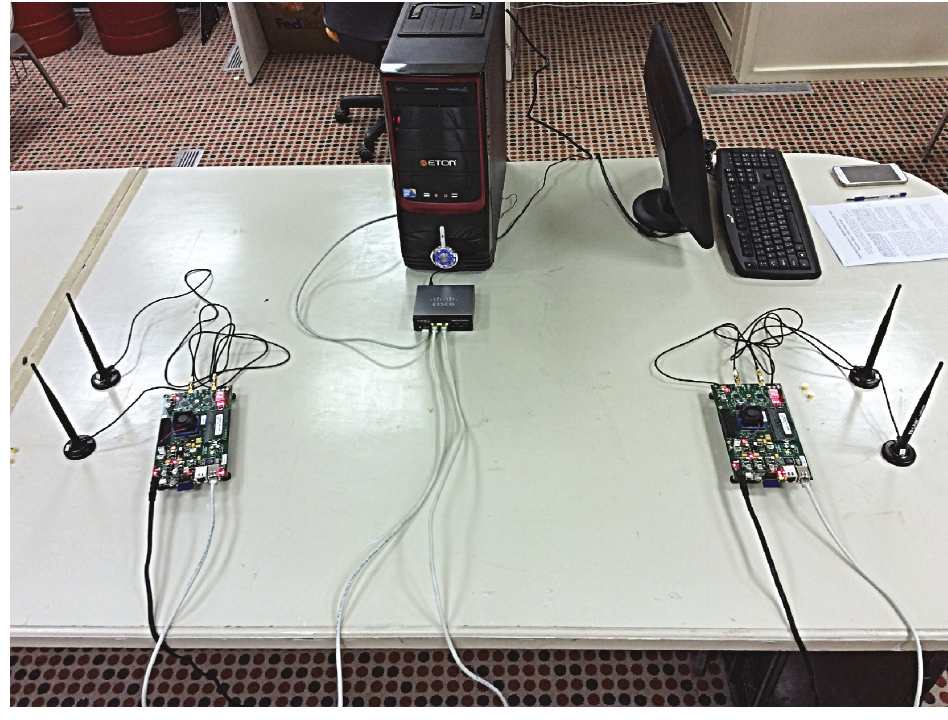
Figure 4: The physical layout of the experimental